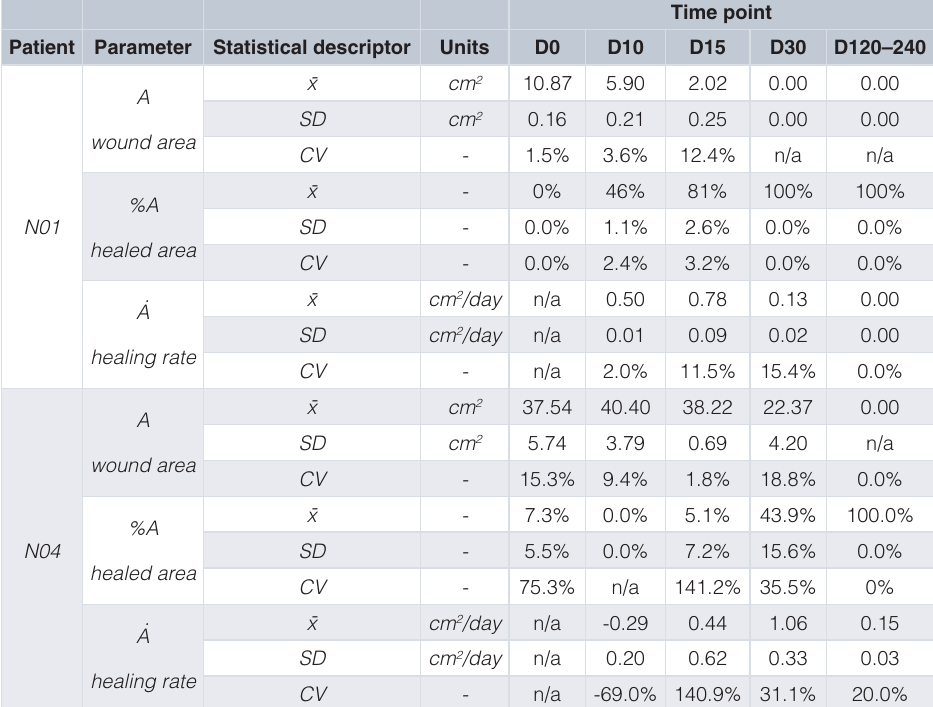
Table 2. Quantitative wound healing parameters. Obtained from analysis of data collected at the time points as per the study protocol, from Day 0 to Day 120–240. The values for parameter A, wound area, were calculated using an image analysis approach of photographs taken at the different time points, A. from which the two other parameters: %A, healed area; and , healing rate, were calculated. x- , mean; SD, standard deviation; CV, coefficient of